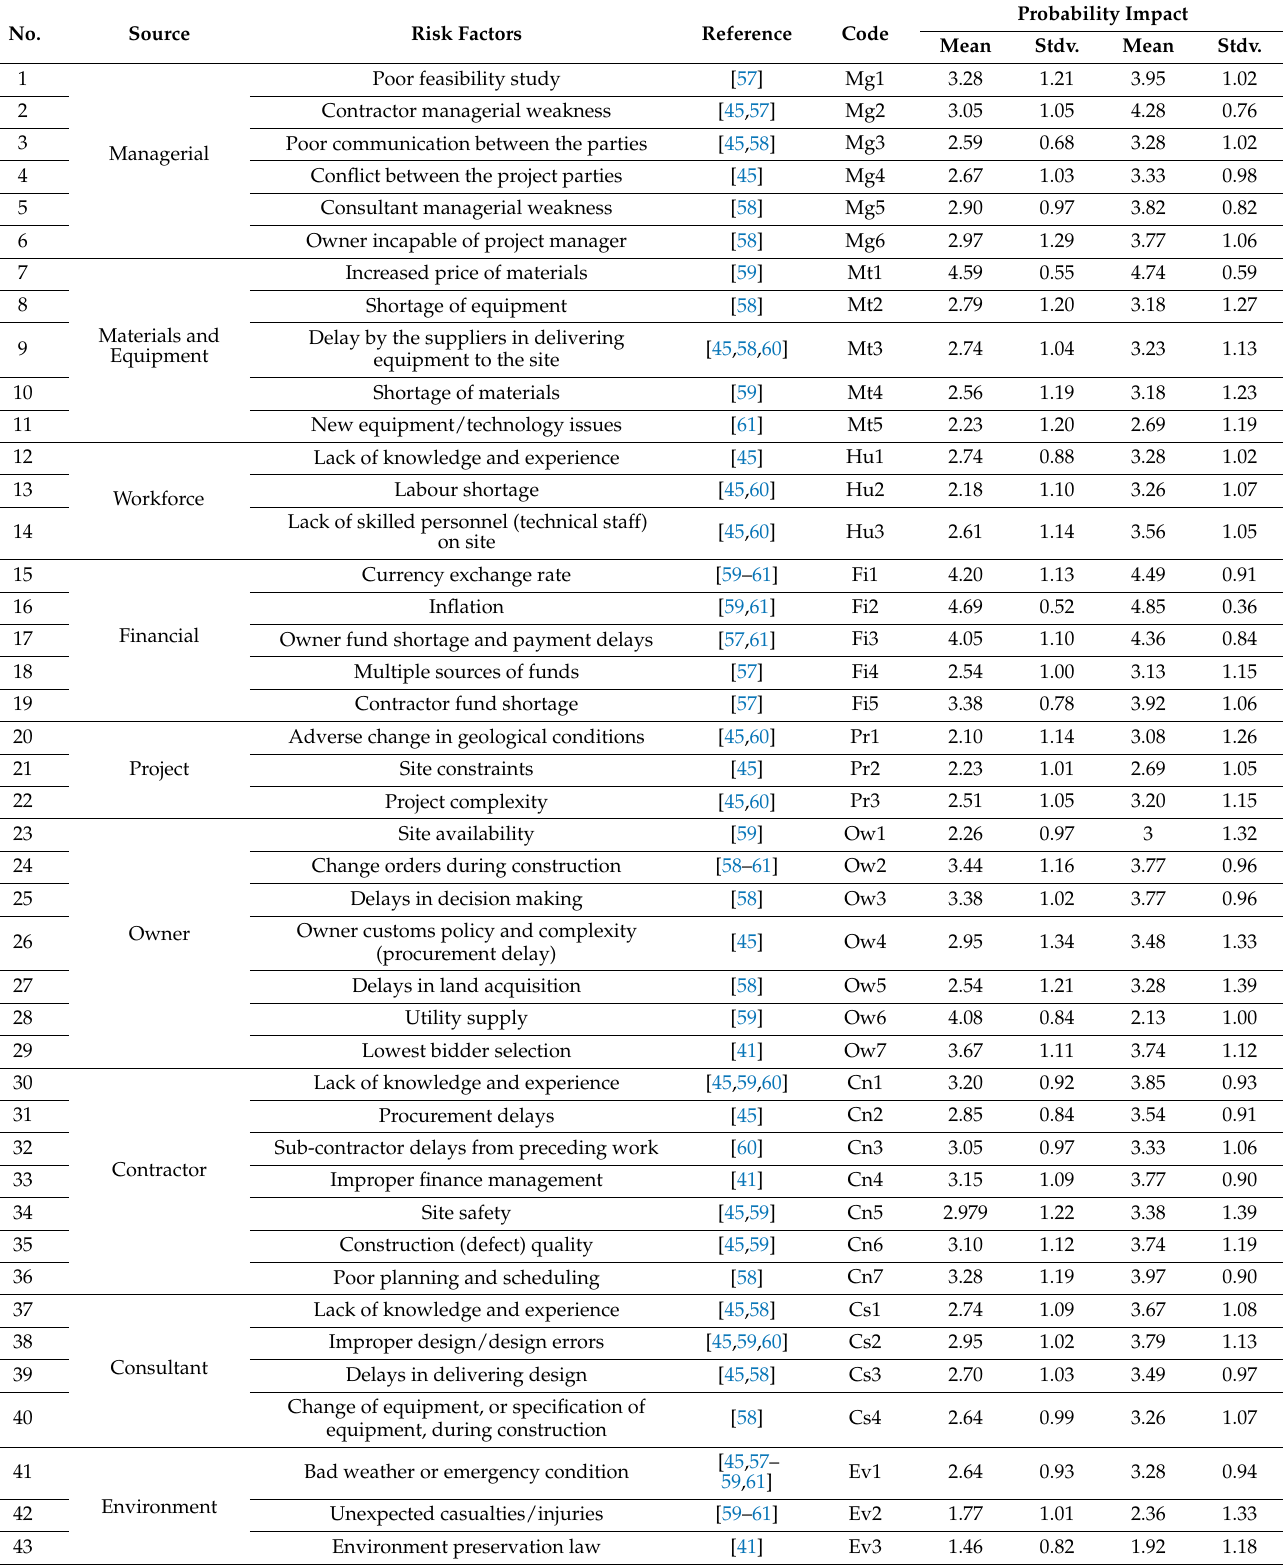
Table 3. Identified Risks’